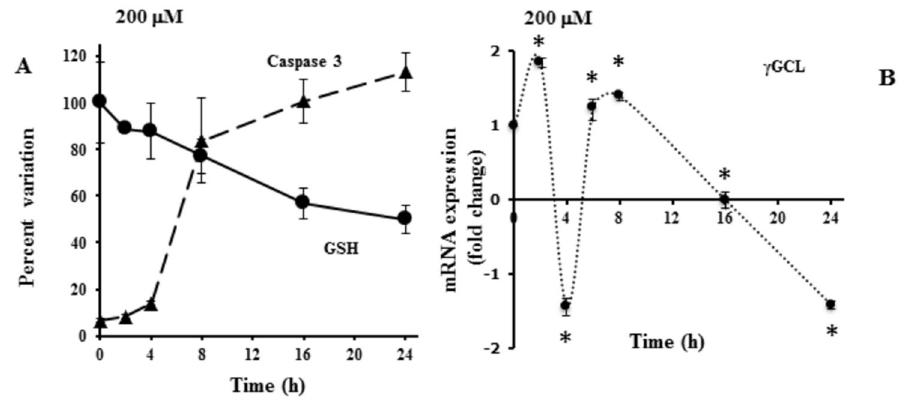
Figure 7. Time-dependent effects of t10,c12-CLA on caspase 3 and cyto-protective defences on A375 cell. Pre-confluent A375 cultures were incubated with 200 μM t10,c12-CLA for the indicated times. After treatments, cytoplasmic cell-extracts were used for the measurement of GSH concentration and caspase 3 activity (A). GSH and caspase 3 activities were expressed as percent variation in comparison to cells harvested at the beginning or at the end of the incubation, respectively. cDNAs were synthesized and used for qRT-PCR analysis of γGCL transcripts (B) at the indicated times. The mRNA levels were finally expressed as fold change in comparison to untreated cells. Results were presented as means ±SD of triplicate data from three independent experiments. SD values lower than 5% were not shown. *Significantly different (P < 0.01) from respective